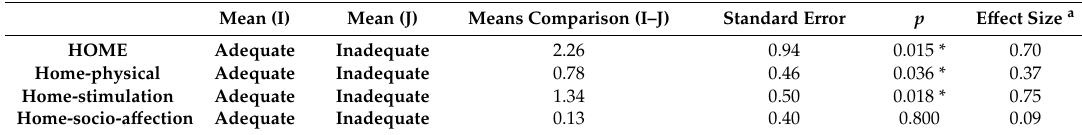
Table 3. E ff ect of cognitive level on adequate / inadequate HOME inventory.